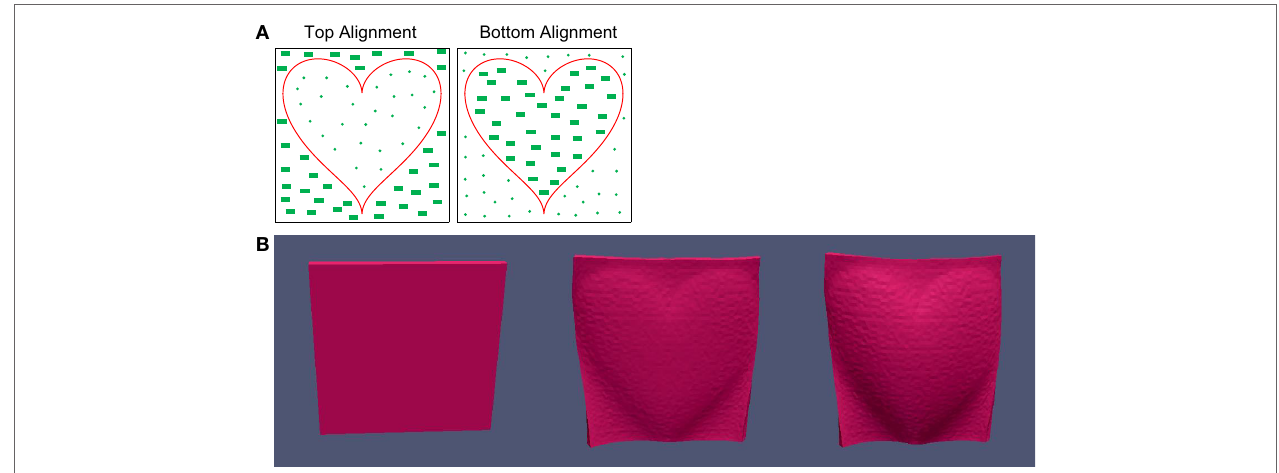
FigUre 7 | (a) Anchoring patterns on top and bottom surfaces with a combination of planar and homeotropic domains. (B) Finite element simulation of actuation on heating of the resulting LCE film; the heart-shaped domain